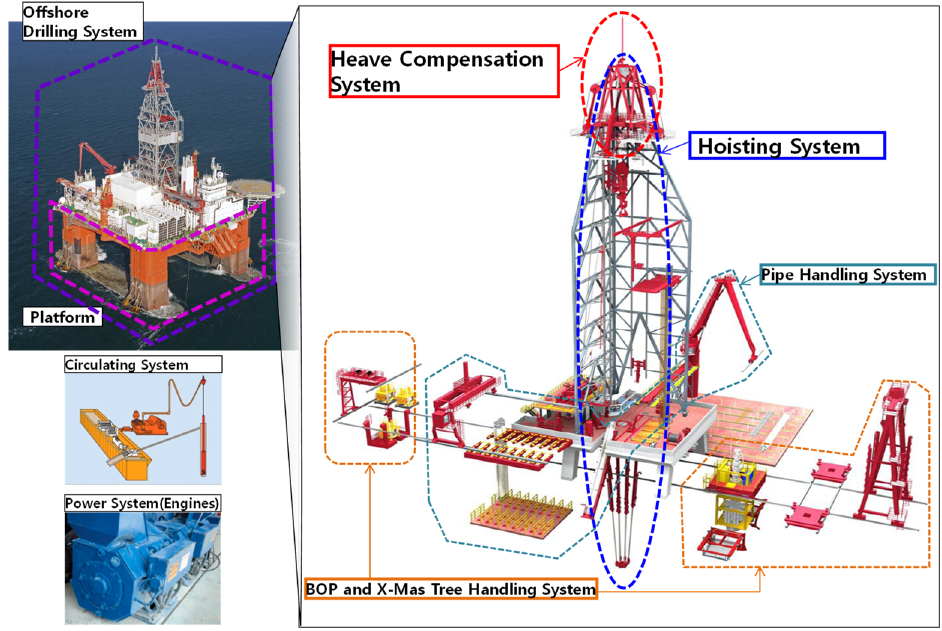
Figure 3. Six main categories of equipment systems on an offshore drilling system.